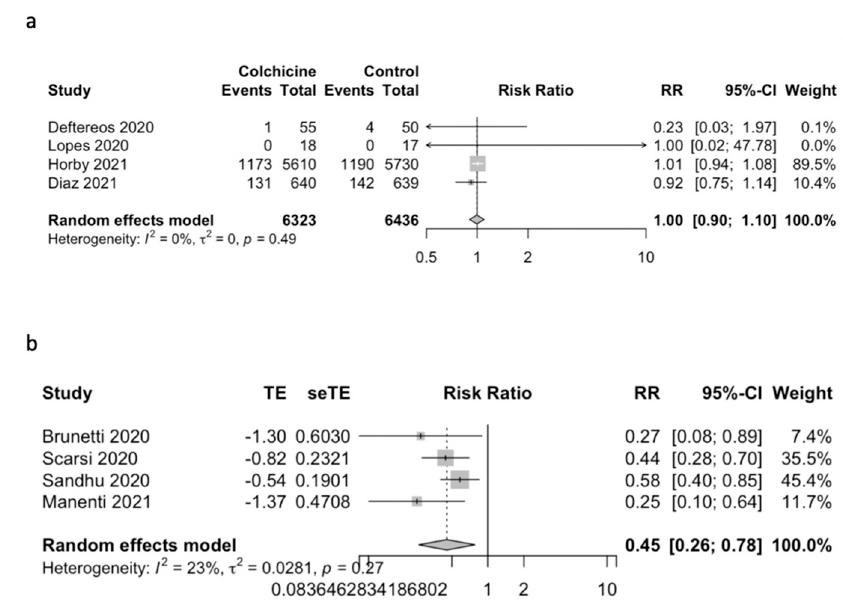
Figure 2. Forest plot of primary outcome: ( a ) RCT studies; ( b ) NRSI studies.